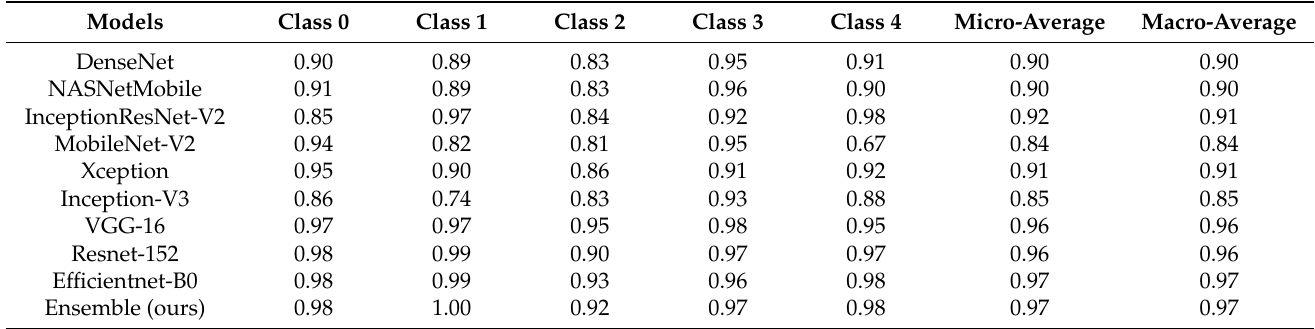
Table 7. Comparison of the AUC values for proposed ensemble architecture with other fine-tuned DL models. The classes 0, 1, 2, 3, 4 represent Cercospora, Healthy, Miner, Phoma, and Rust, respectively.